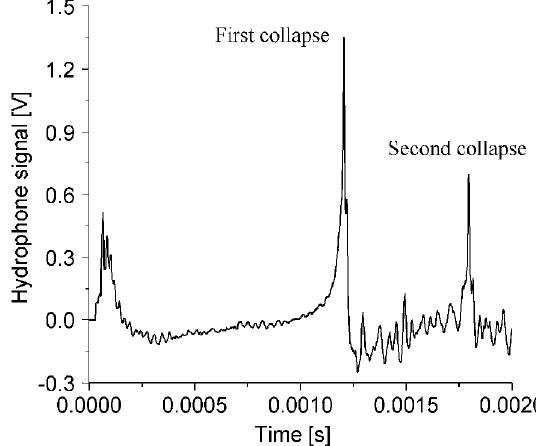
Fig. 1. Typical voltage signal of cavitation bubble collapsing in the liquid measured by PVDF hydrophone. In this study the bubble is generated by a low voltage discharge into crossing wires [3], [5]. This technique provides a simple way of producing spherical bubbles of different diameters. The disadvantage of